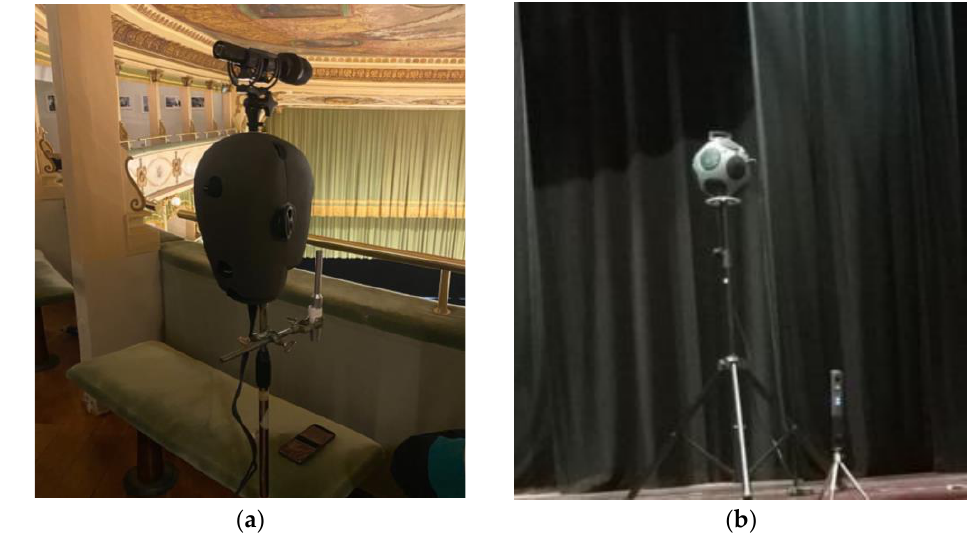
Figure 5. Installation of receivers ( a ) and sound source ( b ) during the survey.